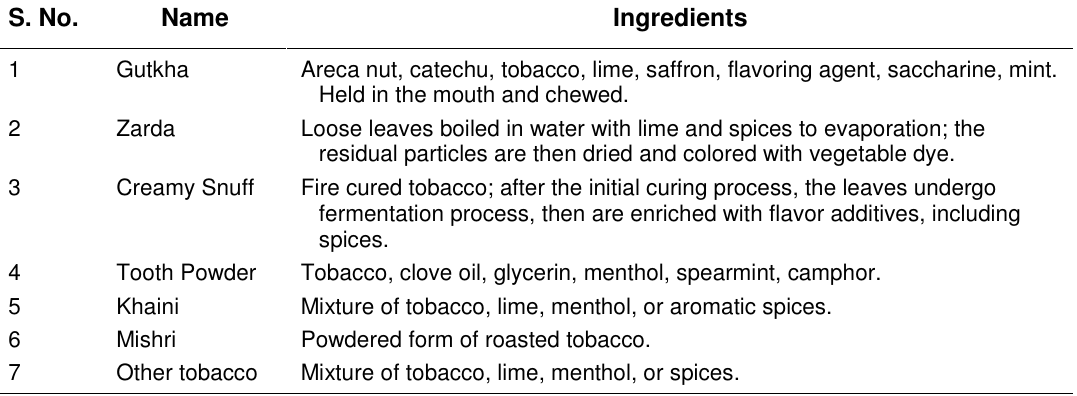
Common Ingredients Used for Flavoring of